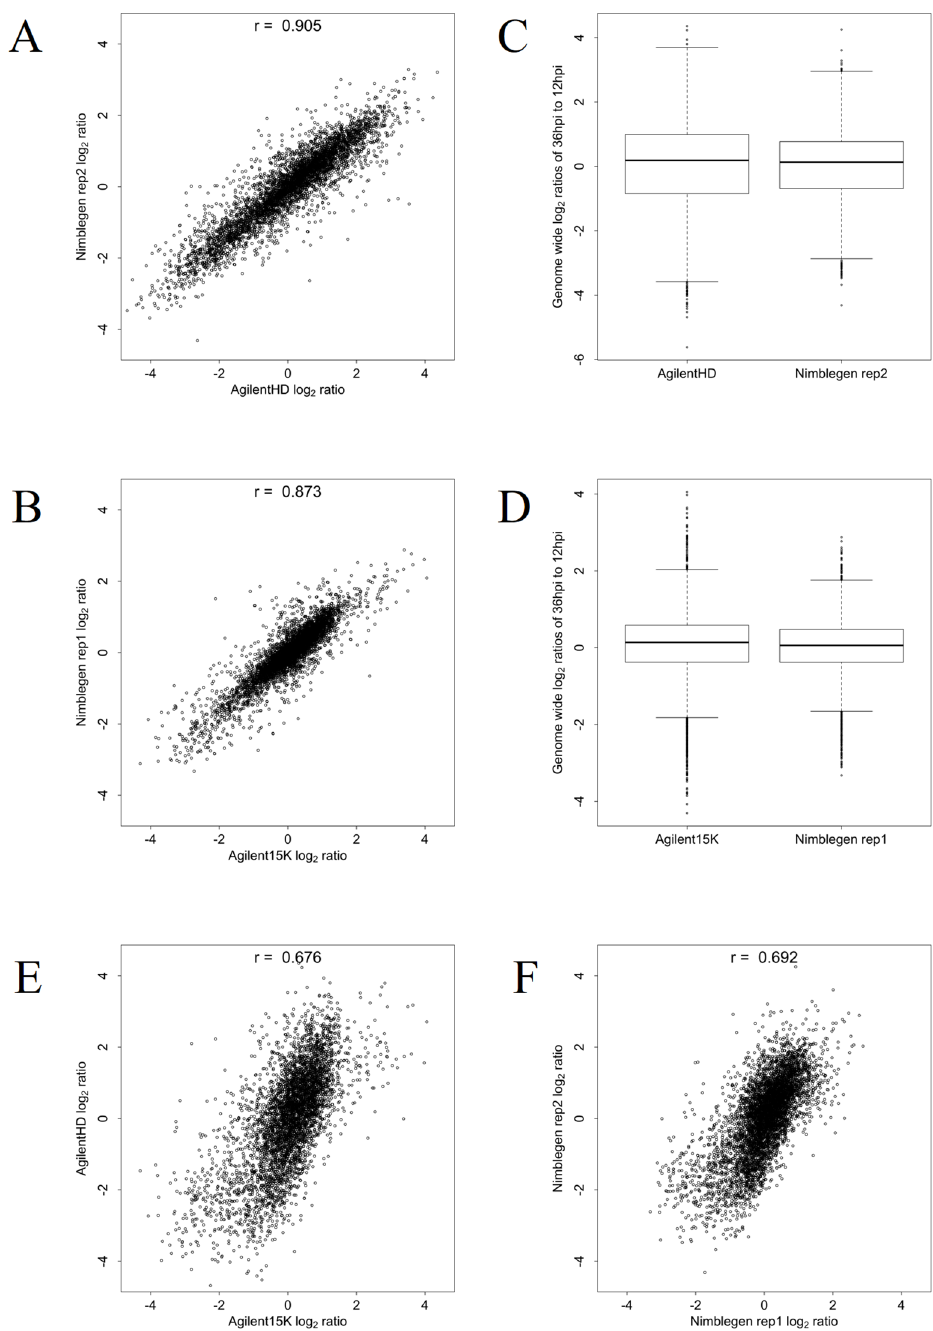
Fig 2. Differentially expressedgenes are replicated with high concordance on the exon arrays. Log 2 ratios of 12 hpi vs. 36 hpi samples were calculatedto determine differentiallyexpressedgenes. The correlationsbetweenlog 2 ratios on the Nimblegenand Agilent HD exon (0.905, A and C) and Agilent 15K arrays (0.873, B and D) show that biologicallyrelevant informationis replicatedacross array platforms. The mean differentialexpressionvalues are comparable between chip platforms, though both Agilent arrays have an overall larger dynamic range (C and D). The correlationbetweenthe Agilent 15K and Agilent HD exon array is 0.676 (E). Different biological samples were hybridized to these two arrays and the correlationvalue matches that of these two biologicalreplicateswhen hybridized on the same platform (F, 0.692) suggesting that the variationseen is due to differences in the